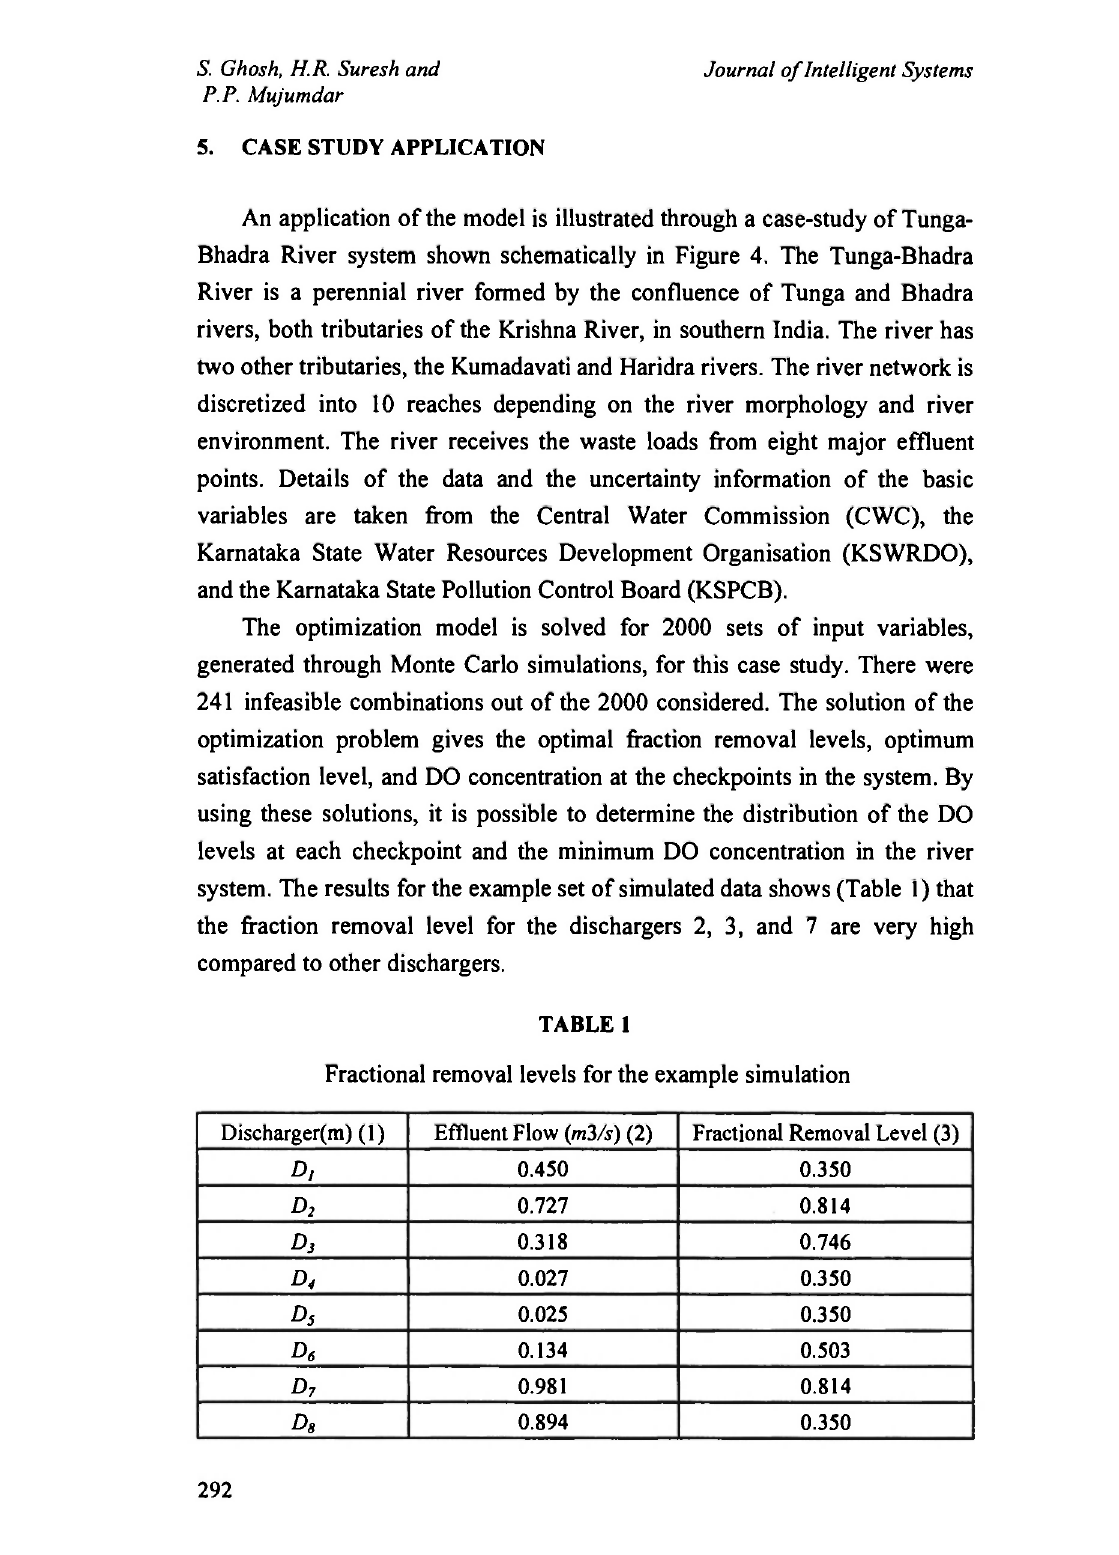
Fractional removal levels for the example